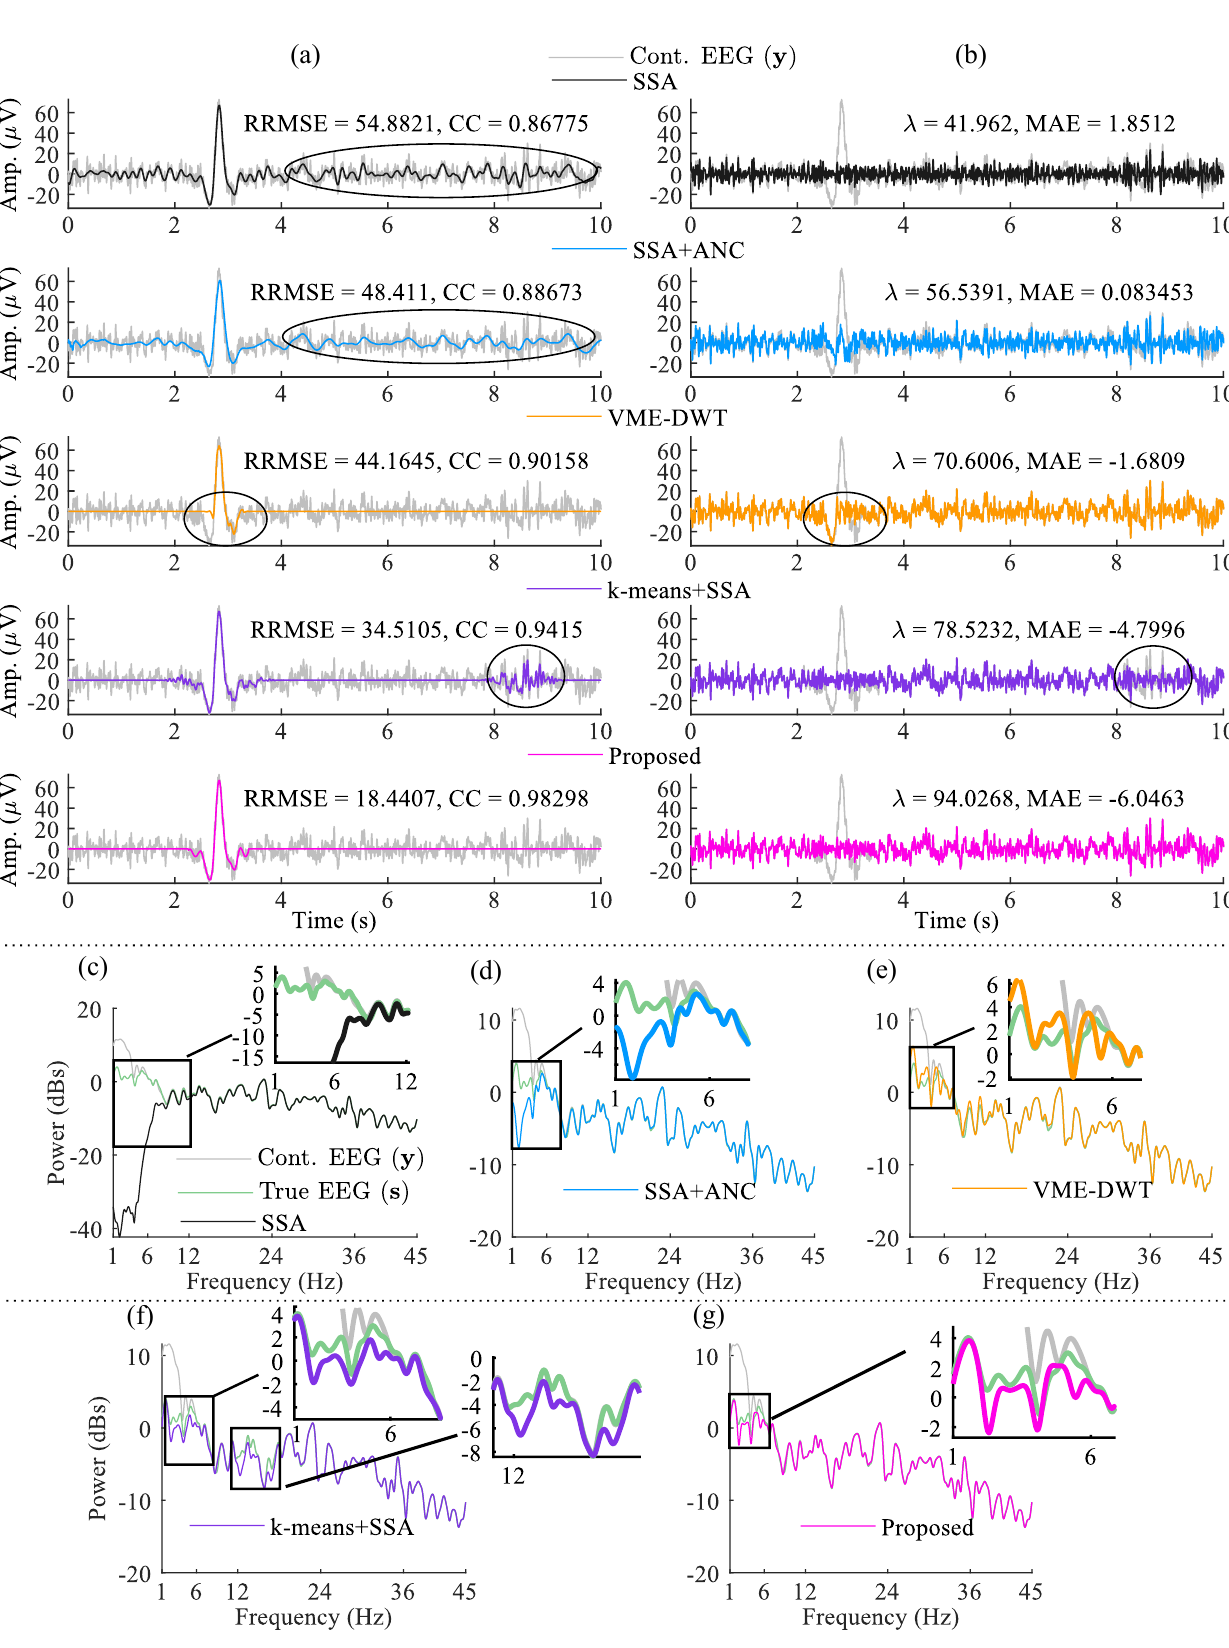
Figure 5. ( a ) The estimated eye-blink artifact (ˆ a ), ( b ) the corrected EEG signals (ˆ s ) using all methods, for the artifact mixing constant p = 0.5. ( c – g ) the power spectrums of the true EEG ( s ) , the contami- nated EEG ( y ), and the corrected EEG signals of all